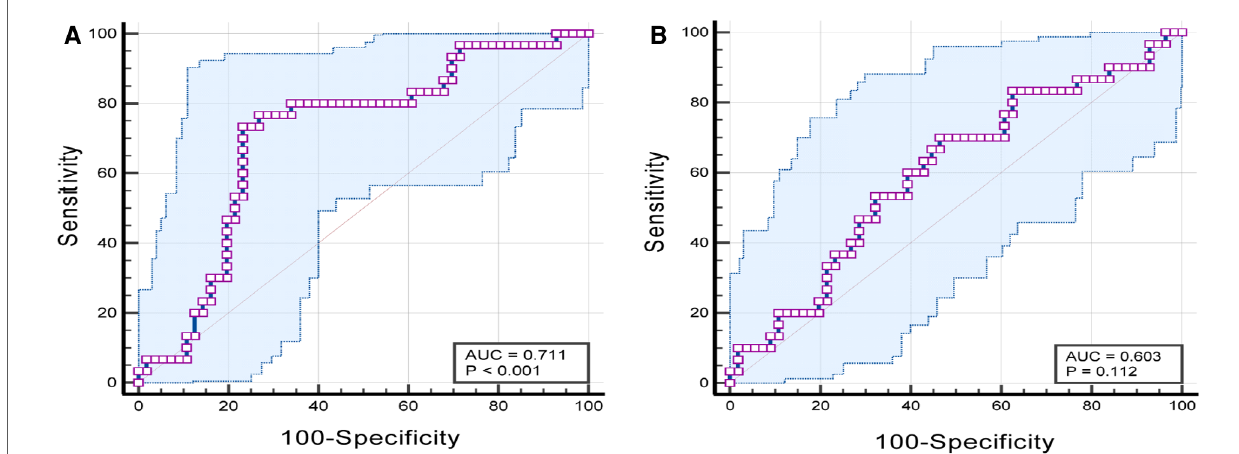
FIGURE 1 ( A ) ROC curve of PONV diagnosis predicted by NLR parameters; ( B ) ROC curve of PONV diagnosis predicted by PLR parameters. ROC, receiver operating characteristic curve; PONV, postoperative nausea and vomiting; NLR, neutrophil-to-lymphocyte ratio; PLR, platelet-to-lymphocyte